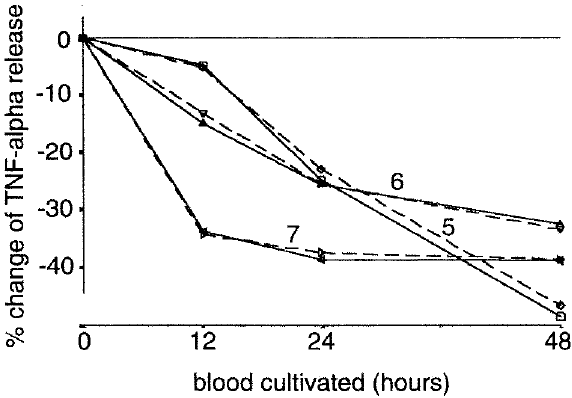
FIG. 2. Effect of cyclooxygenase-2 (COX-2) inhibition on tumor necrosis factor- a (TNF- a ) release in lipopolysacchar- ide (LPS)-stimulated blood cultures of three healthy women 24h after ingestion of 80mg aspirin. For subjects 5, 6 and 7, LPS-stimulated blood cultures before and 24h after aspirin intake were prepared without and with the COX-2 inhibitor DFU (10 m M in dimethylsulfoxide). TNF- a in culture super- natants was determined by a screening line immunoassay. The change in TNF- a release by aspirin intake was calculated as the percentage of values obtained before aspirin inges- tion. Solid lines, change in TNF- a release without DFU; dashed lines, change in TNF- a release in the presence of